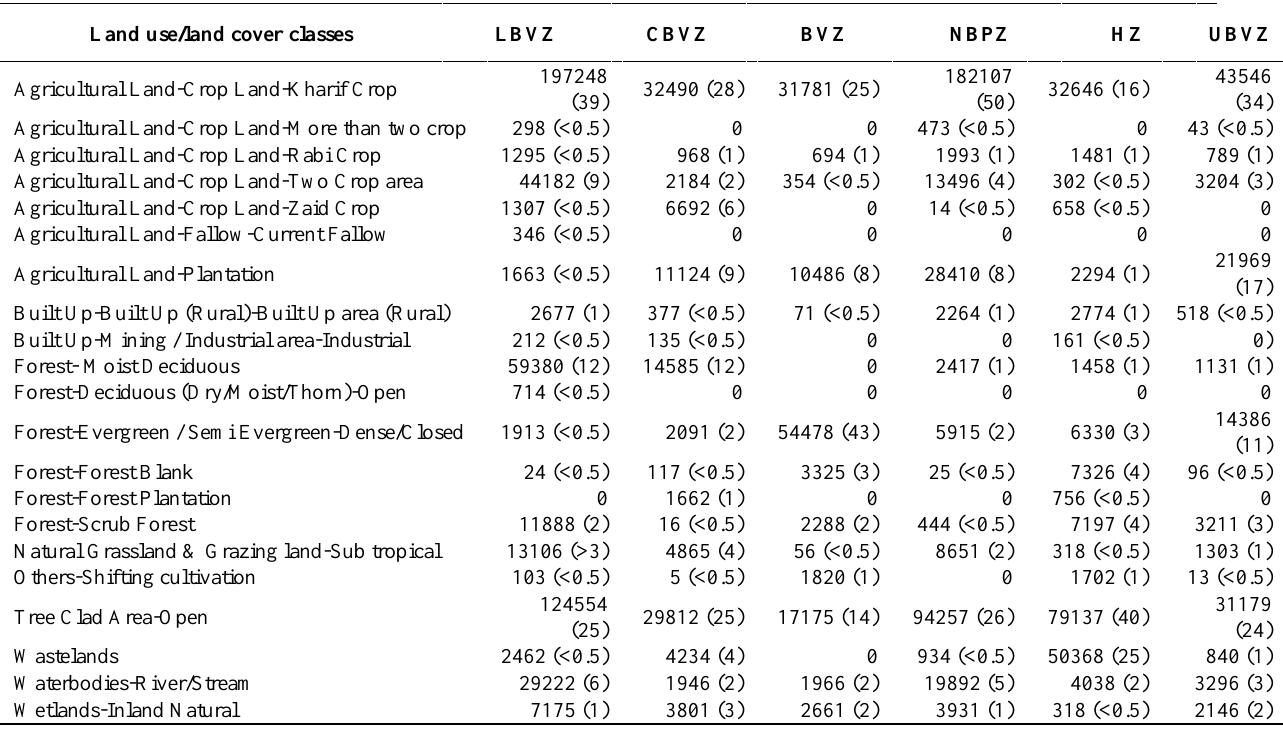
Table 2. Land use/land cover classes within three kilometers buffer of villages under malaria hotspots Land use/land cover